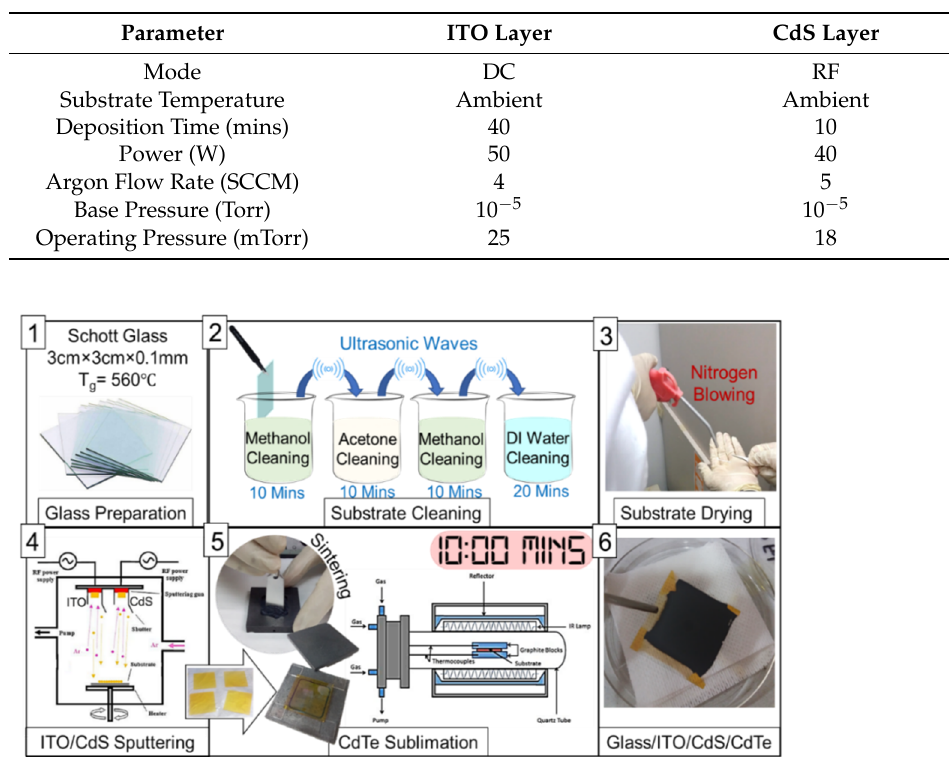
Table 1. Deposition parameters of sputtered ITO and CdS layers.